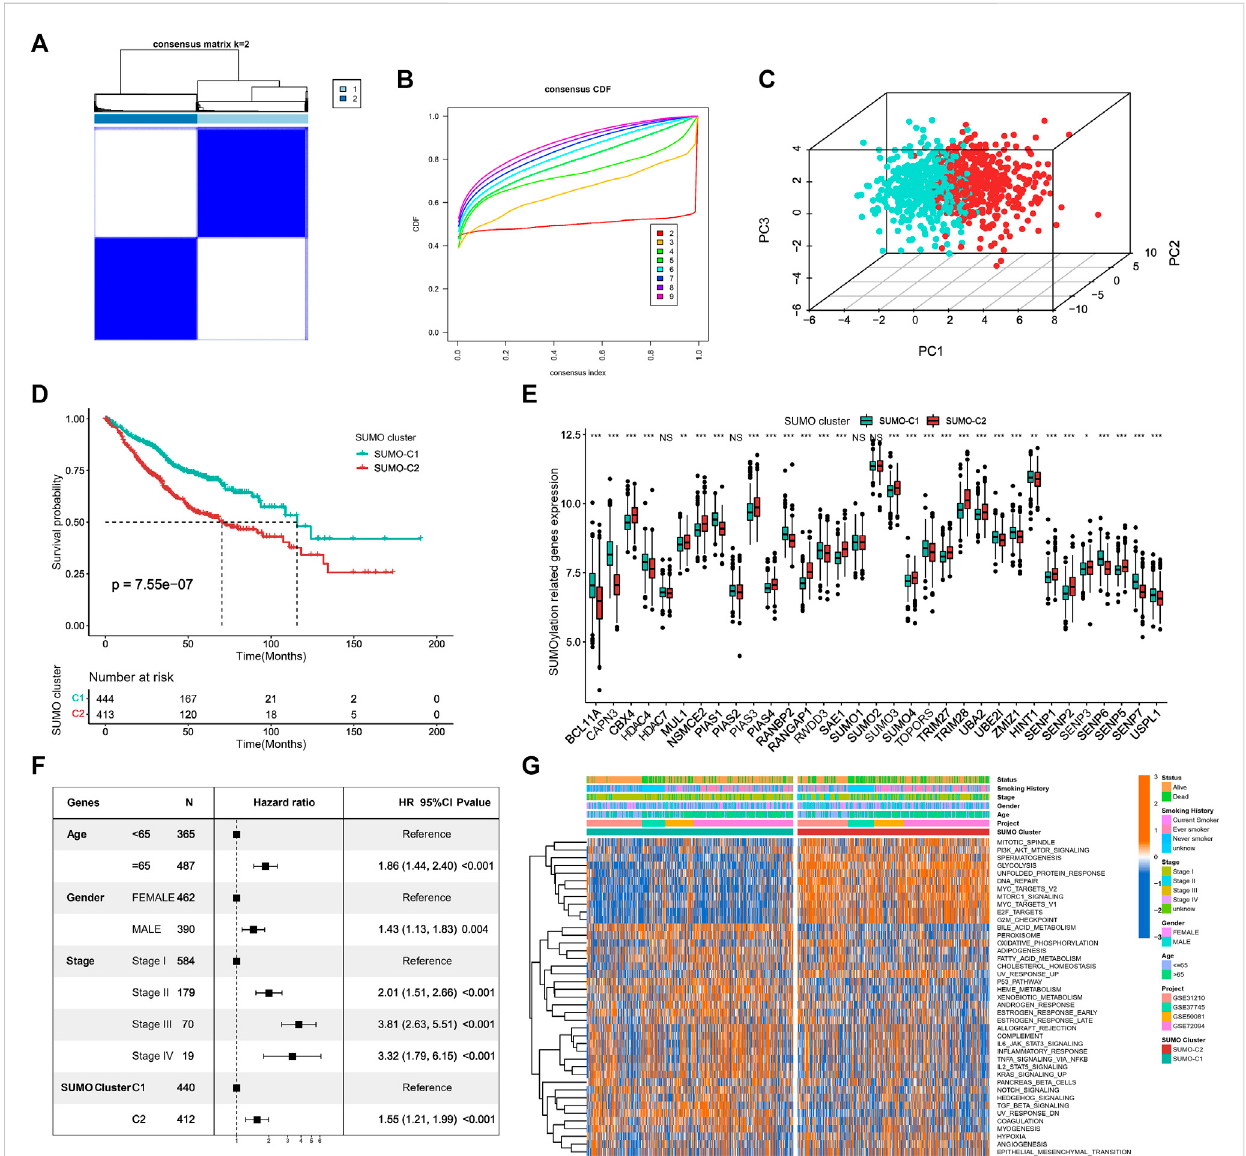
FIGURE 3 Identi fi cation of SUMOylation patterns and their associated biological functions. (A) Unsupervised cluster analysis based on 33 SUMOylation regulatory genes, K = 2. (B) The cumulative distribution curve (CDF) suggests that the optimal K value for unsupervised clustering is 2. (C) Principal component analysis (PCA) based on mRNA expression data of SUMOylation regulatory genes. (D) Kaplan-Meier curves for overall survival OS of two SUMOylation patterns for a total of 857 lung adenocarcinoma samples (including 444 SUMO-C1 and 413 SUMO-C2 cases). (Log-Rank test p = 7.55e-07). (E) SUMOylation regulatory genes were signi fi cantly differentially expressed between the two SUMOylation models. (F) SUMOylation patterns can be an independent prognostic factor for lung adenocarcinoma. (G) Heatmap showing the GSVA scores of the biological pathways of the